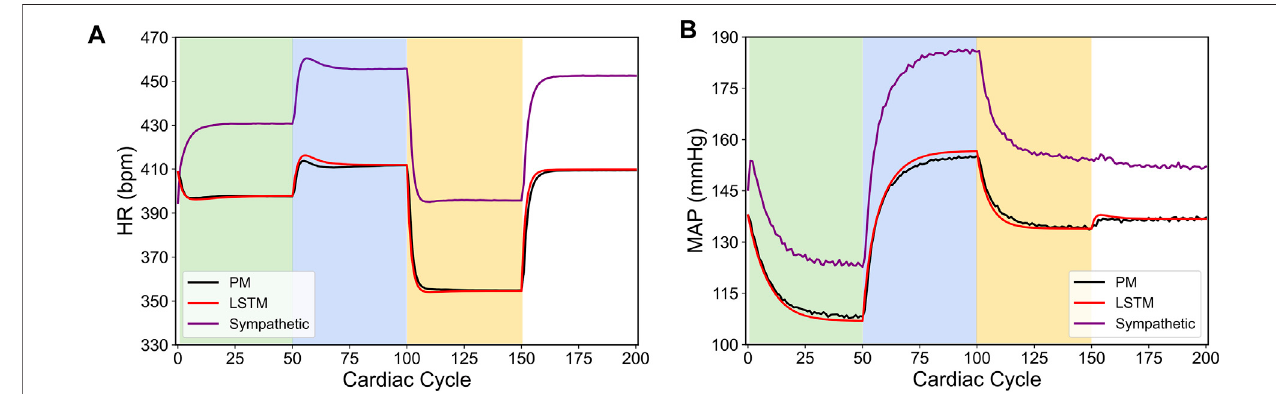
FIGURE 9 | Comparison between the physiological outputs predicted from the modi fi ed in silico physiological model of an overactive sympathetic system (Sympathetic, shown inpurple),the original in silico physiological model (PM,shown inblack) and LSTM model (shownin red) inresponsetothevagus nervestimulation (VNS) for200 simulated cardiac cycles. (A) shows the heart rate(HR, bpm) and (B) shows themean arterialblood pressure(MAP, mmHg). Forcycles 1 – 50 (light green), location 1 was active with a pulse width of 0.36 ms and pulse frequency of 31 Hz. For cycles 51 – 100 (light blue), location 2 was active with a pulse width 0.19 ms and apulsefrequency17 Hz.Forcycles101 – 150(yellow), location3wasactivewithapulsewidthof0.42 msandapulsefrequencyof47 Hz.Thelast50cyclesdid not have any locations